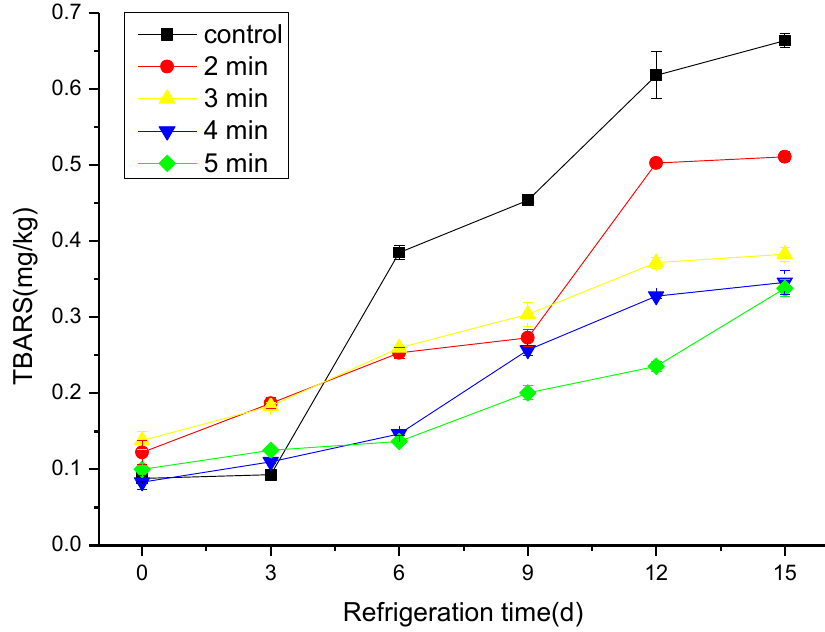
Figure 4. Changes in TBARS of cold stored hairtail fish exposed to CAP at 50 kV voltage for various treatment times: 2, 3, 4, and 5 min. The non-treated sample was included as a control. Table 2. Effect of Cold Atmospheric Plasma treatment at 50 kV voltage on the variation of the total color difference of hairtail during cold storage